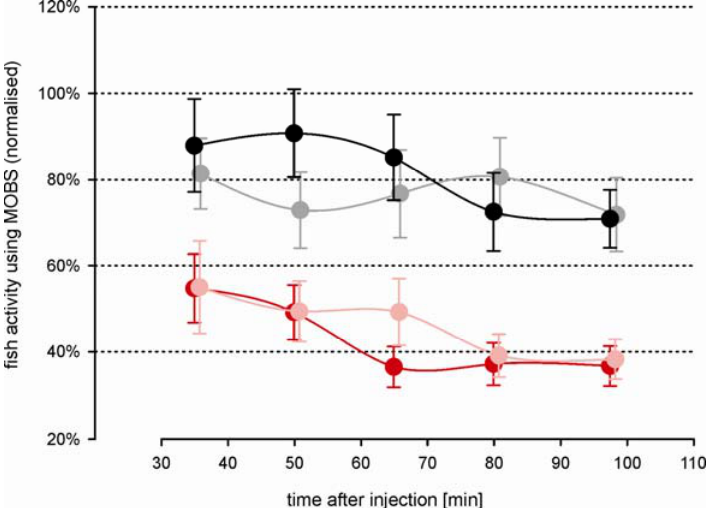
Figure 5. Impact of intramuscular saline solution on the time-course changes in zebrafish activity. Fish were treated with 10% acetic acid injection alone (dark red), in combination with 3µL saline solution (intramuscular injection, light red), in combination with 6 mg/kg morphine (intramuscular injection, gray), and in combination with 6 mg/kg morphine and 3µL saline solution (black). Treatments are from different studies, all values were recorded using the MOBS system and are normalized to the median of pre-treatment activity (100%). Fish activities for periods of 15 min are shown as Winsorized mean ± standard error, connected with a solid line.